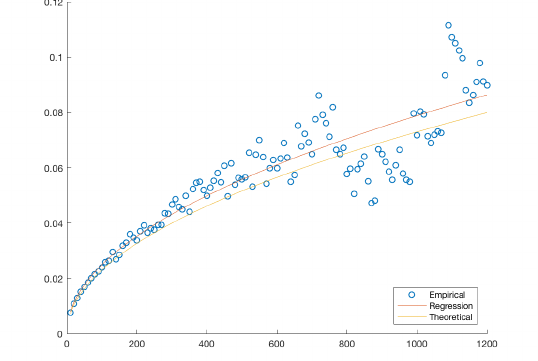
Figure 7. A qualitative comparison of the regression to the theoretical model. For APPL, AMZN and GOOG, we have used a Markov chain generated from 16 quantiles taken on the upward movements and downward movements. For INTC and MSFT, we have taken the CHPDO coefficient since a different coefficient is not possible with the other